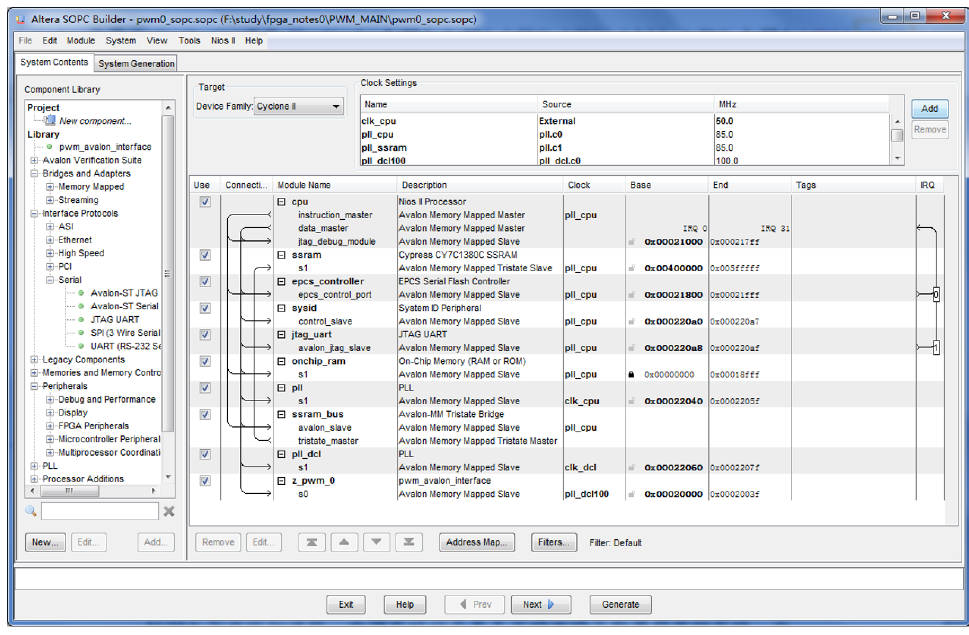
Figure 9. Control system